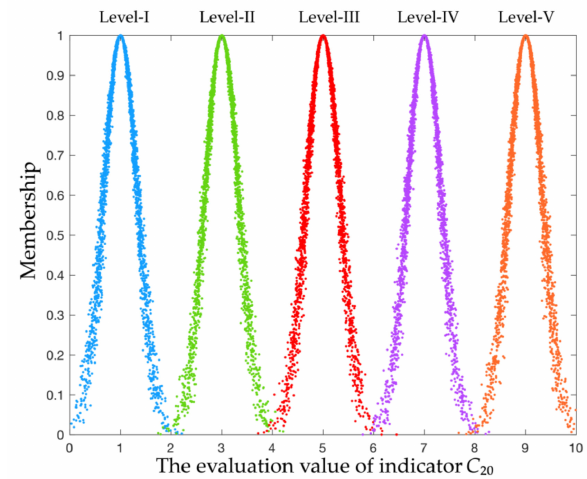
Figure 1. Hierarchical normal cloud model based on the “3 E n ” rule.